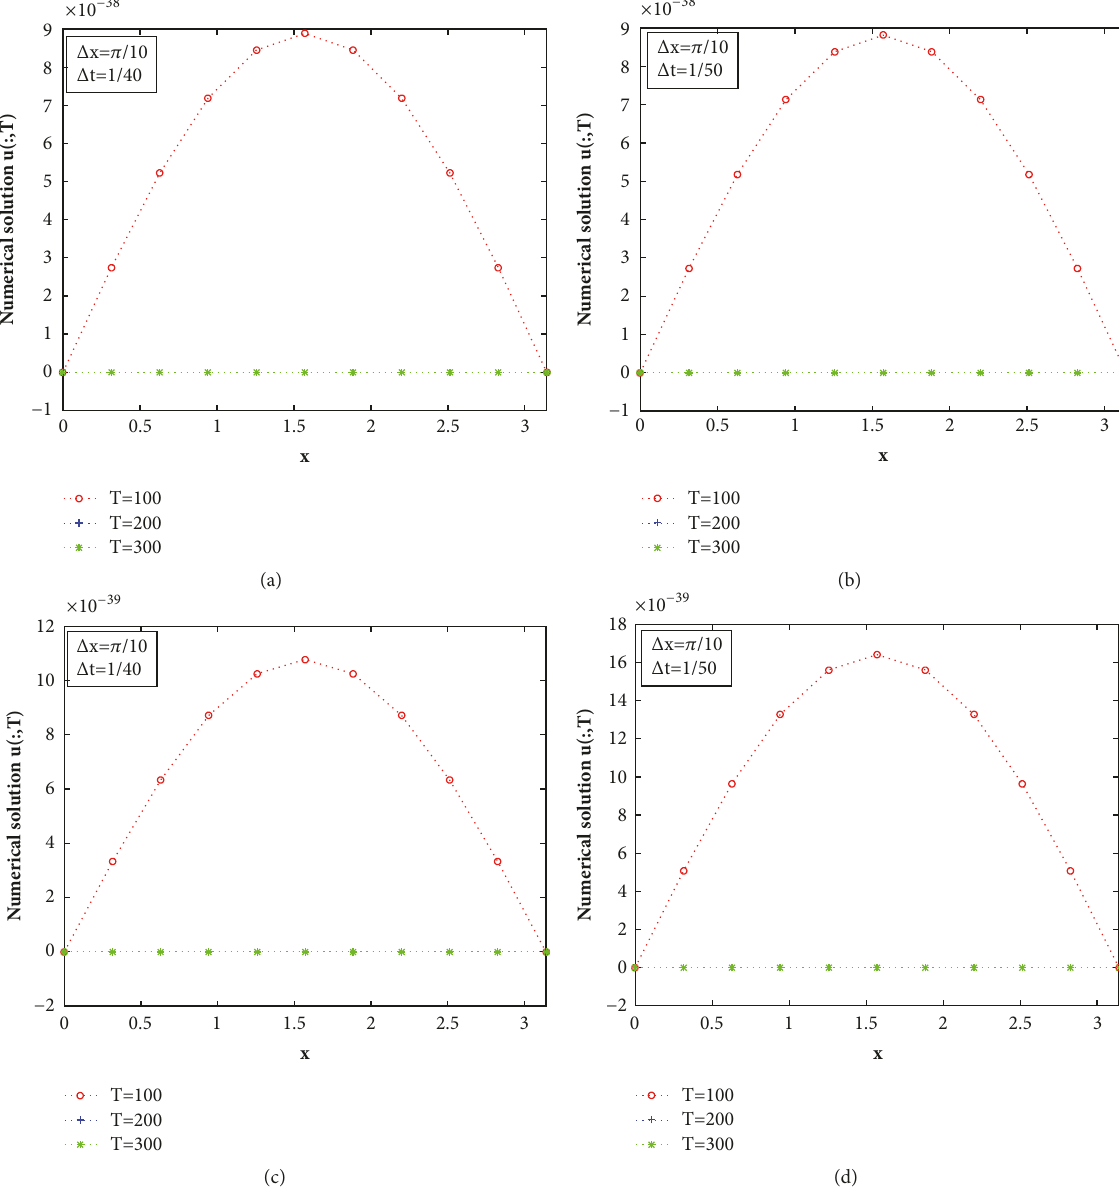
Figure 6: Numerical solution at the different final time T for varying parameters 𝜃 and 𝑚 ( 𝜏 = 1 ). (a) 𝜃 = 0.5 and 𝑚 = 40 . (b) 𝜃 = 0.5 and 𝑚 = 50 . (c) 𝜃 = 1 and 𝑚 = 40 . (d) 𝜃 = 1 and 𝑚 = 50